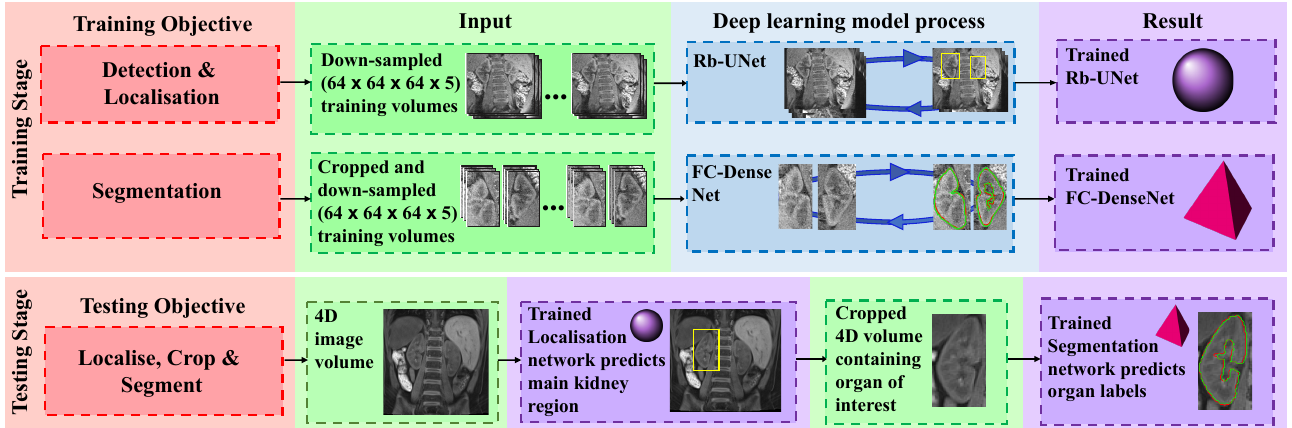
Figure 1. Overview of the proposed automatic kidney segmentation approach. The training stage simultaneously develops a network (3D Rb-UNet) for localising the organ and a segmentation network (3D FC-DenseNet) to predict the labels that correspond to kidney and non-kidney tissue. The testing stage processes an original scan (a 4D volume), performs a coarse segmentation to generate a bounding box capturing the main kidney region and then processes the cropped image volume to predict the labels of that